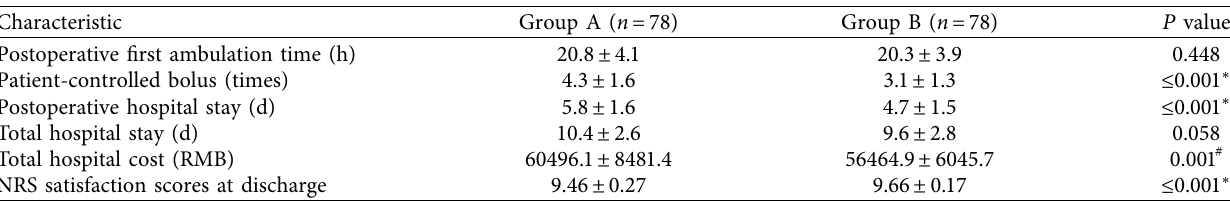
Figure 4: Mean erythrocyte sedimentation rate (ESR) before operation (Pre) and postoperative 48 hours (POH48), # P < 0 . 05. Table 2: Secondary outcomes.